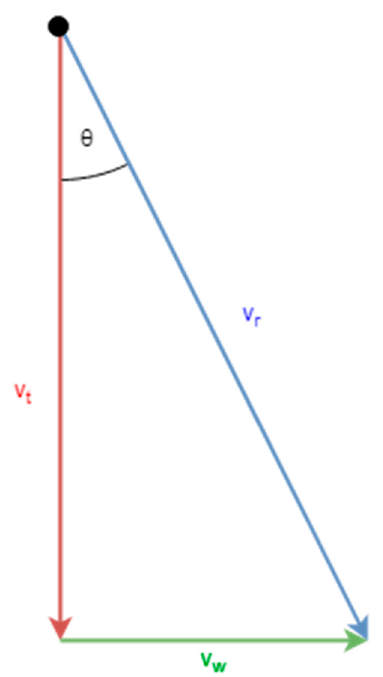
Figure 4. Relationship between the resultant velocity ( v r ), wind speed ( v w ), and terminal hailstone velocity ( v t ).